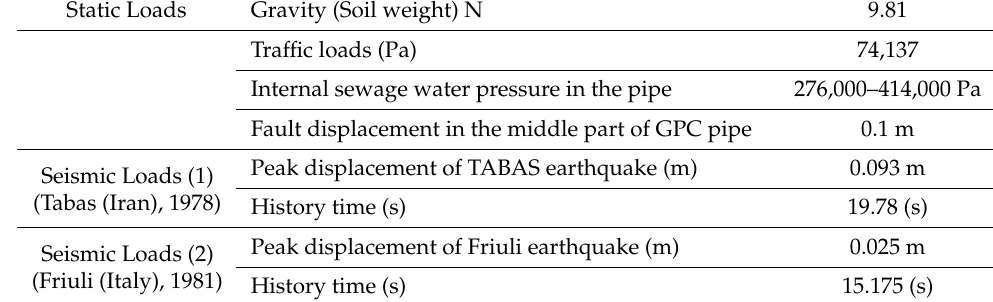
Table 9. The values of the seismic and static loadings applied in FE.